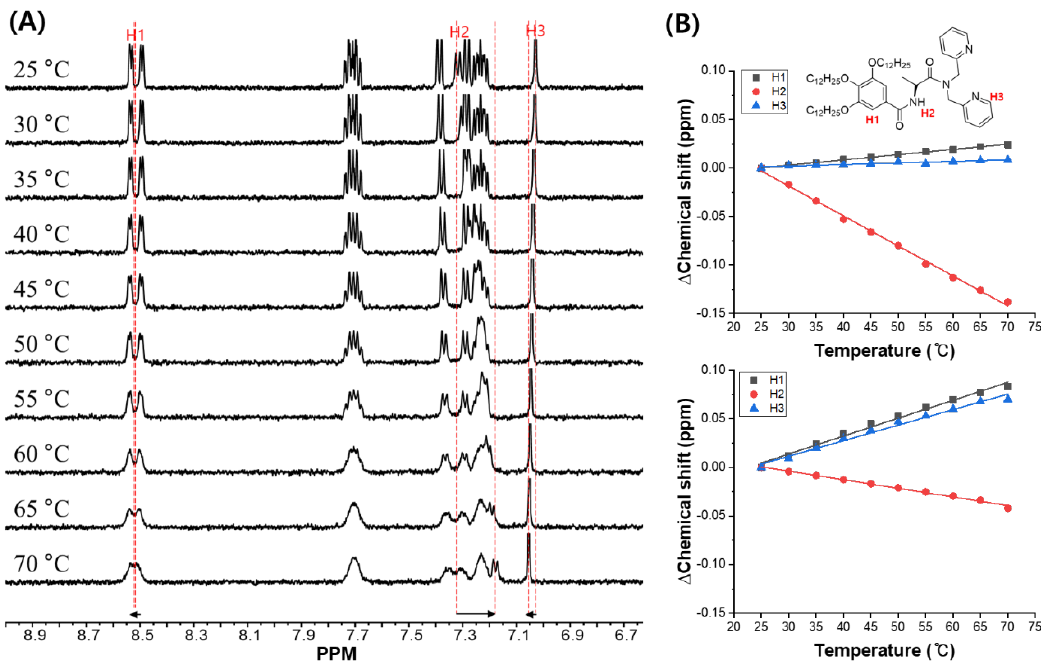
Figure 4. ( A ) Temperature-dependent 1 H NMR spectra of 1 (2 mM) in ACN-d 3 . ( B ) Plot for chemical shift of H1, H2 and H3 without (upper) and with (below) Zn 2+ (0.5 equiv.) from 25 to 70 °C.